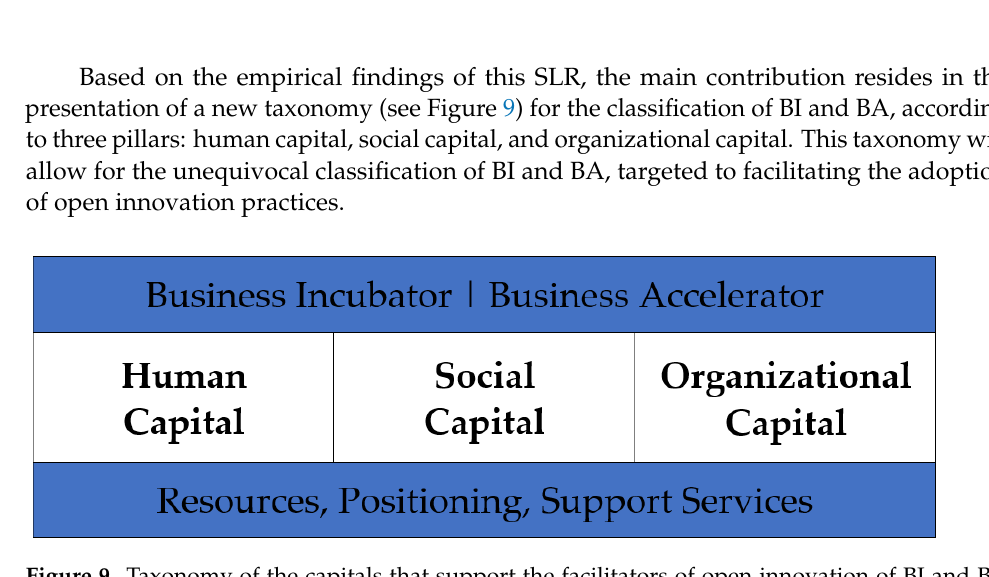
Figure 9. Taxonomy of the capitals that support the facilitators of open innovation of BI and BA (Source: Own elaboration).